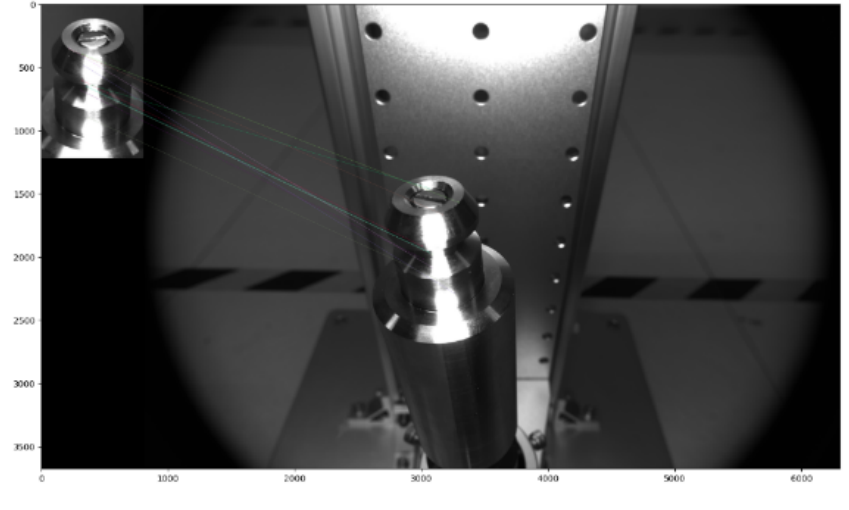
Figure 5. Template and matching feature map.